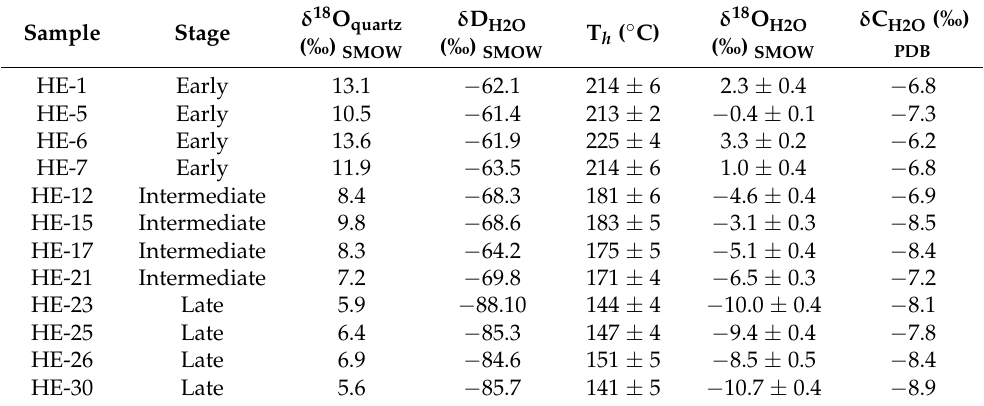
Table 2. Oxygen, hydrogen, and carbon isotope data from hydrothermal quartz of the Harla gold deposit. Sample